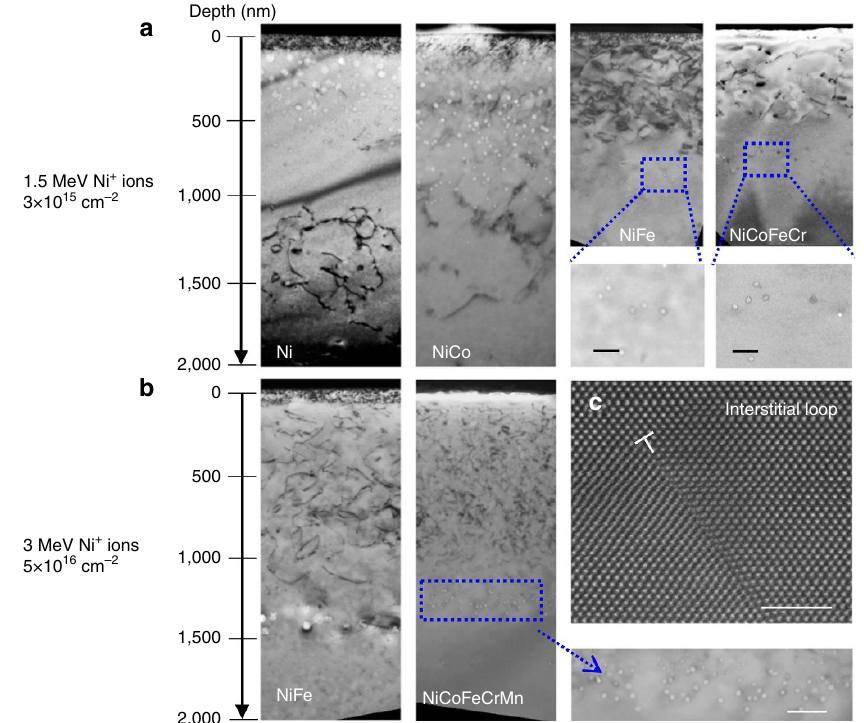
Figure 2 | Distribution of dislocations and dislocation loops in nickel and Ni-containing SP-CSAs. ( a ) Cross-sectional TEM images of nickel, NiCo, NiFe and NiCoFeCr irradiated by 1.5MeV Ni þ to 3 (cid:2) 10 15 cm (cid:3) 2 at 773K, scale bars in the zoomed images are 50nm. ( b ) Cross-sectional TEM images of NiFe and NiCoFeCrMn irradiated by 3MeV Ni þ ions to 5 (cid:2) 10 16 cm (cid:3) 2 at 773K, scale bar in the zoomed image is 100nm. a , b were taken under the two-beam condition with g ¼ 200. ( c ) High-resolution high-angle annular dark field STEM image showing a part of an interstitial loop in NiCoFeCr; scale bar, 2nm.